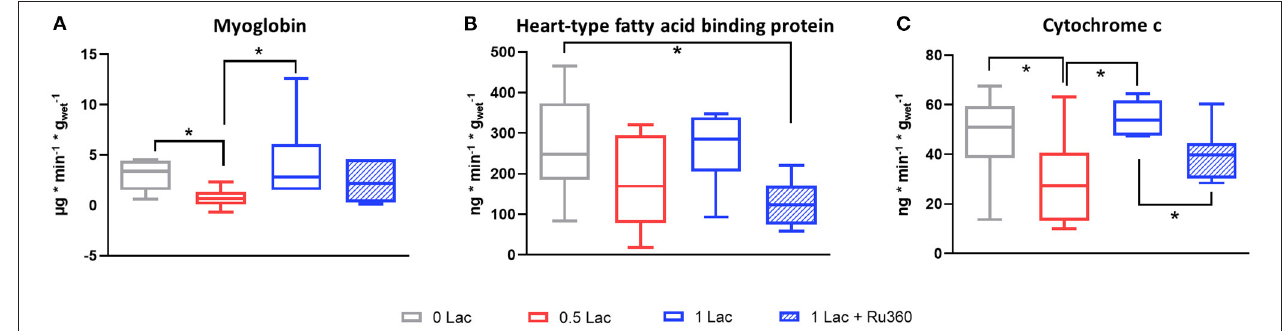
FIGURE 3 | Release of circulating markers of cell death and mitochondrial damage between 10 and 60min of reperfusion. (A) Myoglobin (B) Heart-type fatty acid binding protein (H-FABP) (C) Cytochrome c (cyt c). * p < 0.05; n = 6–14/group. Data are expressed as median, 25–75 percentiles, and range.